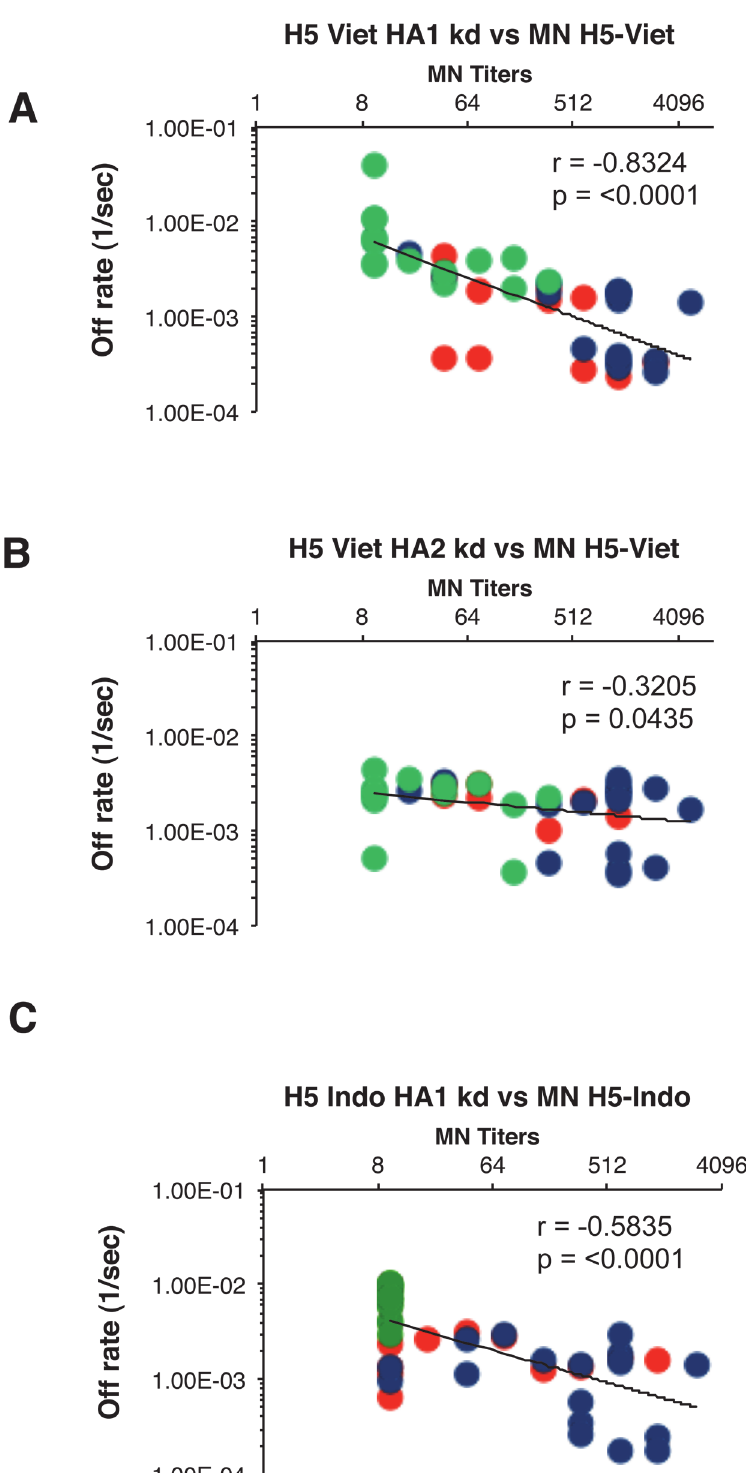
Fig 4. Serum antibody off-rates to H5-Viet-rHA1 (but not rHA2) following heterologous prime-boost strongly correlate with the in-vitro neutralizing capacity against the homologous H5 vaccine viruses. Antibody off-rate constants were determined directly from the serum sample interaction with H5N1 rHA1 or rHA2 proteins using SPR in the dissociation phase. SPR analysis of post-boost vaccination human sera from